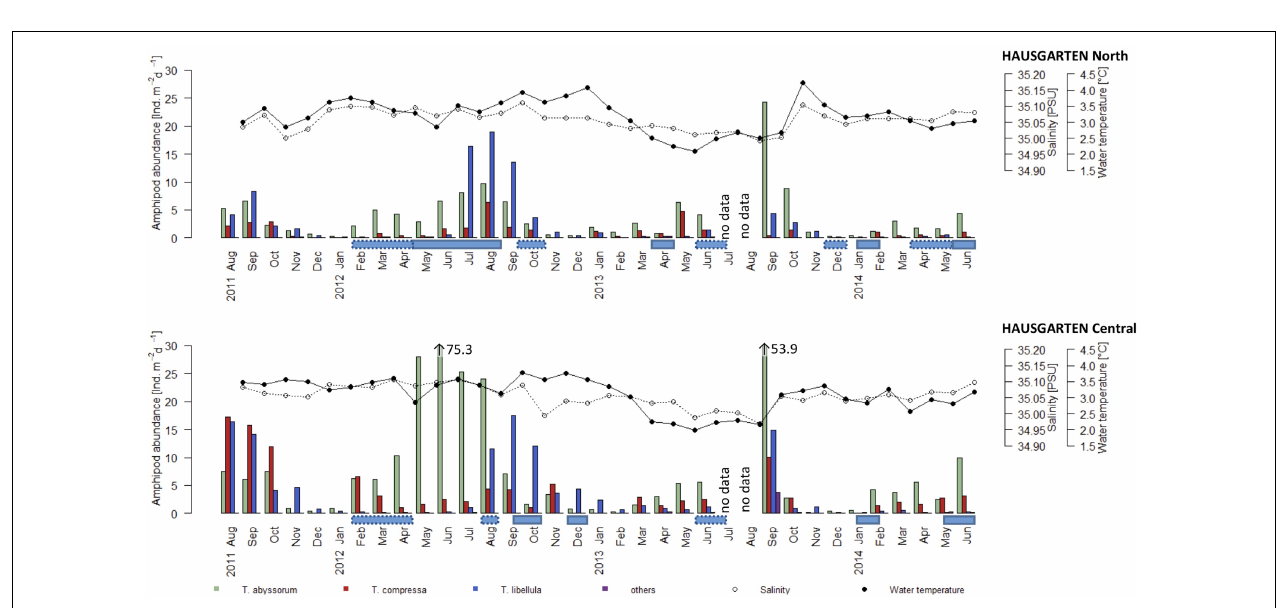
FIGURE 3 | Progression of mean monthly amphipod abundance (Ind.m − 2 d − 1 ) in HAUSGARTEN sediment traps along a latitudinal gradient: northern (upper panel) and central position (lower panel). Note the off-scale values of Themisto abyssorum in the lower panel (dashed boxes = periods of occasional ice cover, solid boxes = permanent ice cover). Connected dots represent the salinity (open circles) and temperature (filled circles) values across the years (for amphipod species color codes, see Figure 2 ).